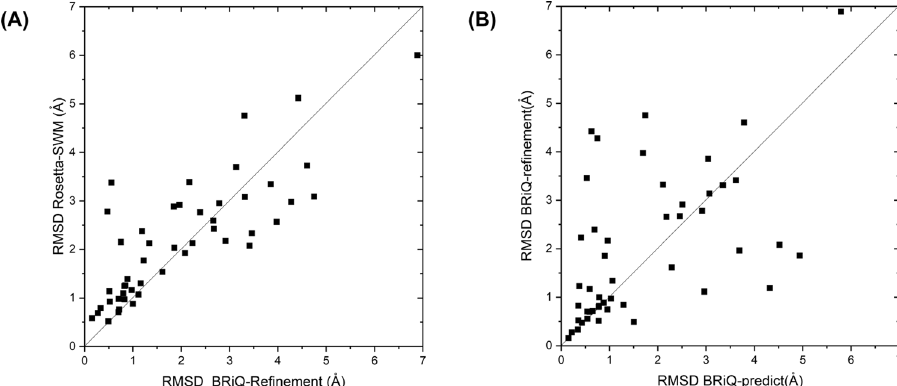
Fig. 2 Re fi nement of Rosetta-SWM models and base-pair-restrained prediction of RNA structural motif by BRiQ. A Re fi ning Rosetta-SWM motif models by BRiQ improves the majority of those model structures with RMSD<2Å as demonstrated by RMSD comparison (lowest RMSD of top 1% before re fi nement on Y -axis versus after re fi nement on X -axis). B Fixing all native base pairs with random initial conformations for all other regions and then folding the remaining structure leads to more accurate motif models for the majority of the motifs than re fi ning Rosetta-SWM models that have pre- assigned, partially fi xed base pairs (Lowest RMSD of top 1% BRiQ-re fi ned models on Y -axis versus lowest RMSD of top 1% BRiQ models with fi xed native base pairs on Data 1). We test our re fi nement method by re fi ning all 88,352 Monte Carlo sampling at low temperature. The lowest RMSD conformations generated by Rosetta-SWM with the NuTree values of top 1% predicted models by the Rosetta and BRiQ algorithm and the BRiQ energy score. The NuTree was con- energies are compared in Fig. 2A. The majority of predicted motif structed with the base-pairing information extracted from conformations (31/48, 64.5%) have an improved RMSD after Rosetta-SWM model, and the BRiQ energy was optimized by BRiQ re fi nement with a median reduction of 0.2 Å RMSD change